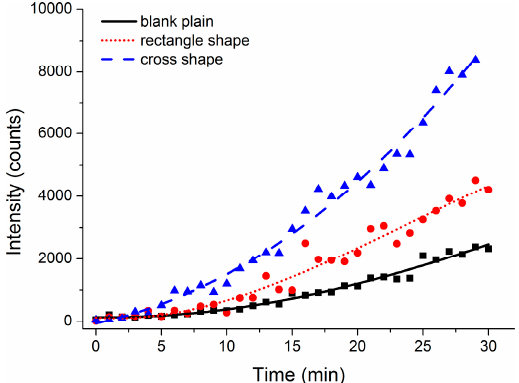
Figure 6. The laser-induced fluorescence intensity of the concentrated Rh6g solvent after an extraction time of half an hour. The velocity of the aqueous and organic phases was set at 2 and 12 mL·h − 1 , respectively.